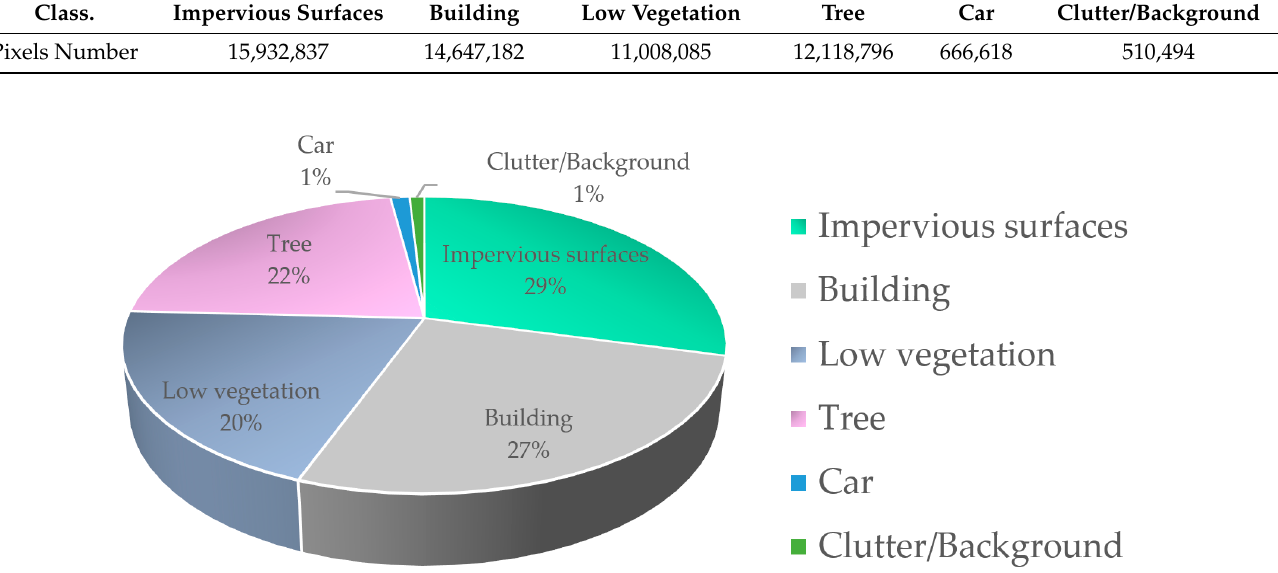
Figure 8. The proportion of pixels for each class in the training set.